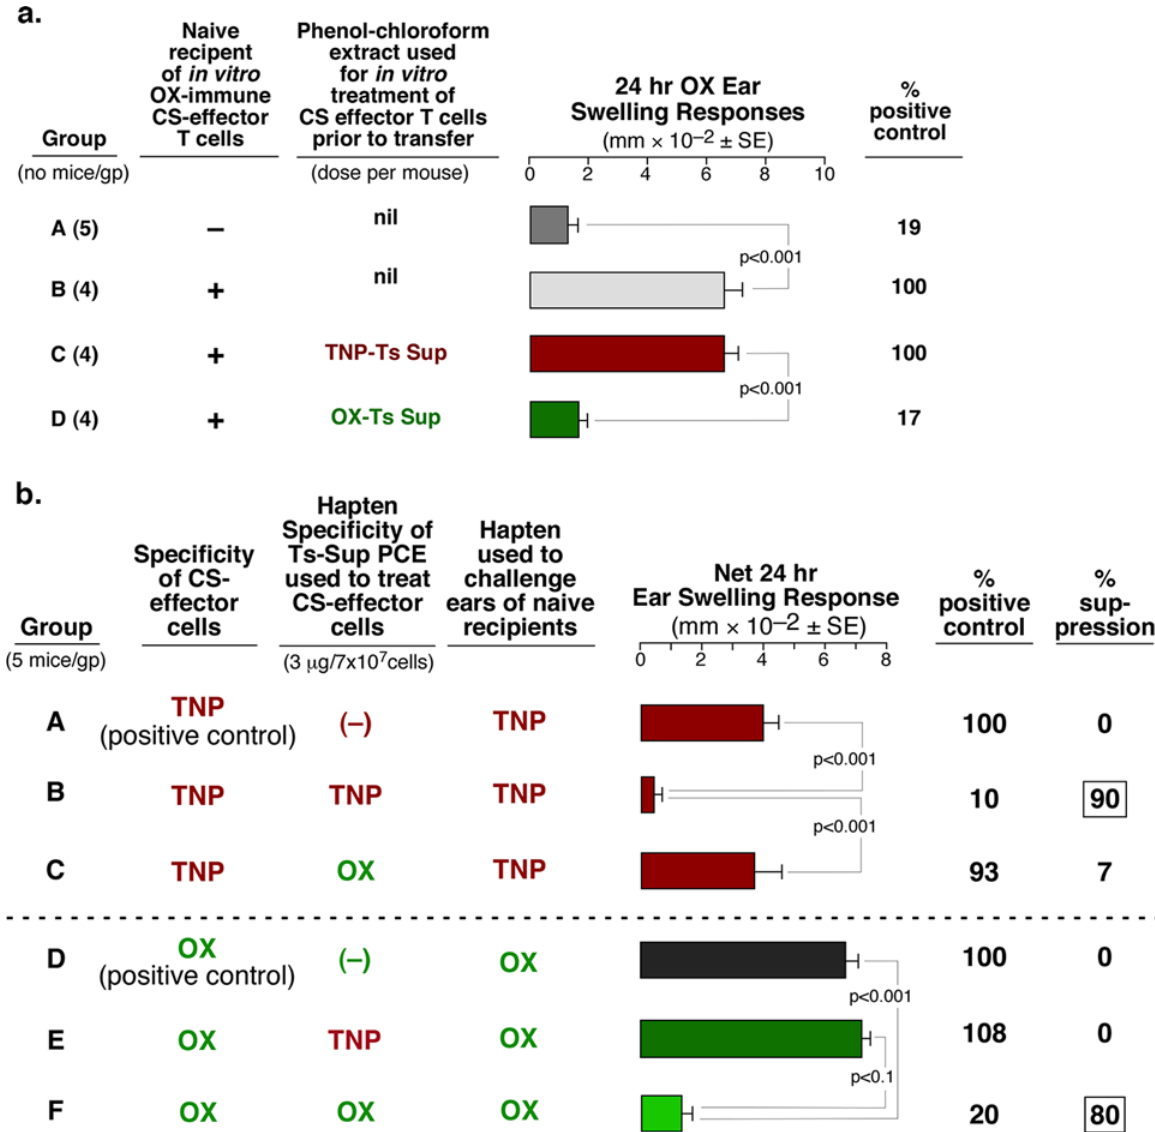
Fig 5. Possible Ag-specific suppression by Ts Sup exRNA PCE. a. OX specific CS-effector cells were suppressed by OX Ts Sup PCE, but not TNP Ts Sup PCE (Group D vs C). b . In a dual reciprocal criss cross Ag-specificity experiment, TNP vs OX-specific CS-effector cells were suppressed by PCE from Ts Sup induced by tolerization with their respective homologous TNP or OX haptens (Groups B and F), but not from mice tolerized with the heterologous hapten (Groups C and E).